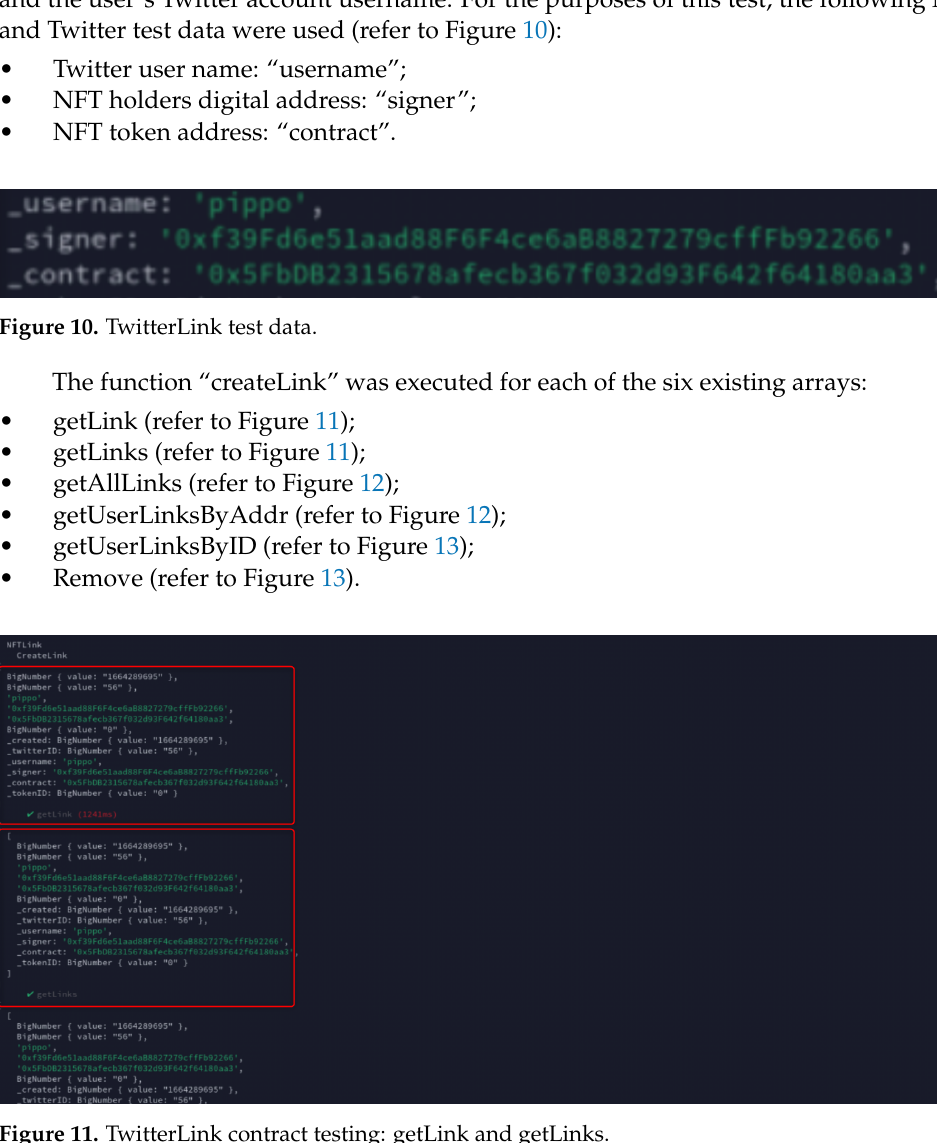
Figure 11. TwitterLink contract testing: getLink and getLinks.